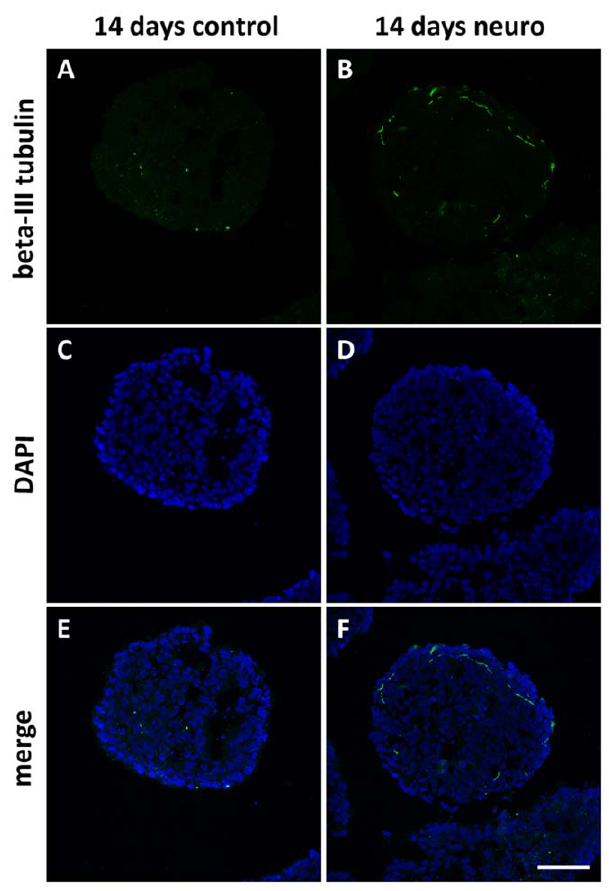
Figure 8. Beta-III tubulin staining is exclusive to 14 days old neural induced embryoid bodies. Beta-III tubulin staining of H9 embryoid bodies (green), A) 14 days old control group; B) 14 days old neural induced group; C and D) DAPI staining (blue); E and F) merge. Scale bar 50 m m.